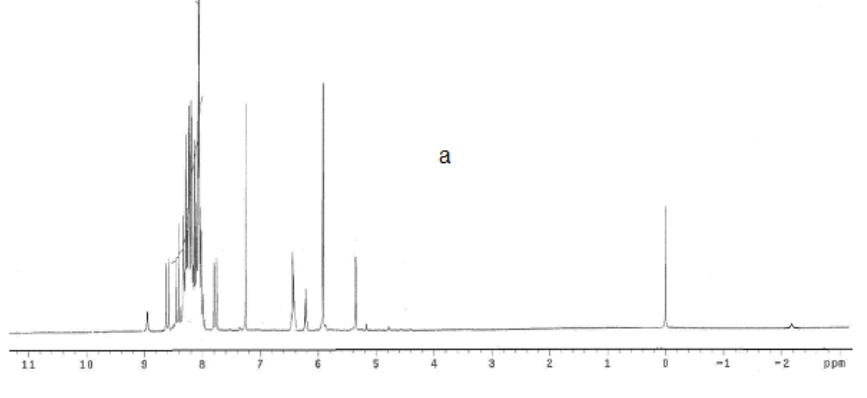
CO /DMF, 60 °C. 2 3 at room 3